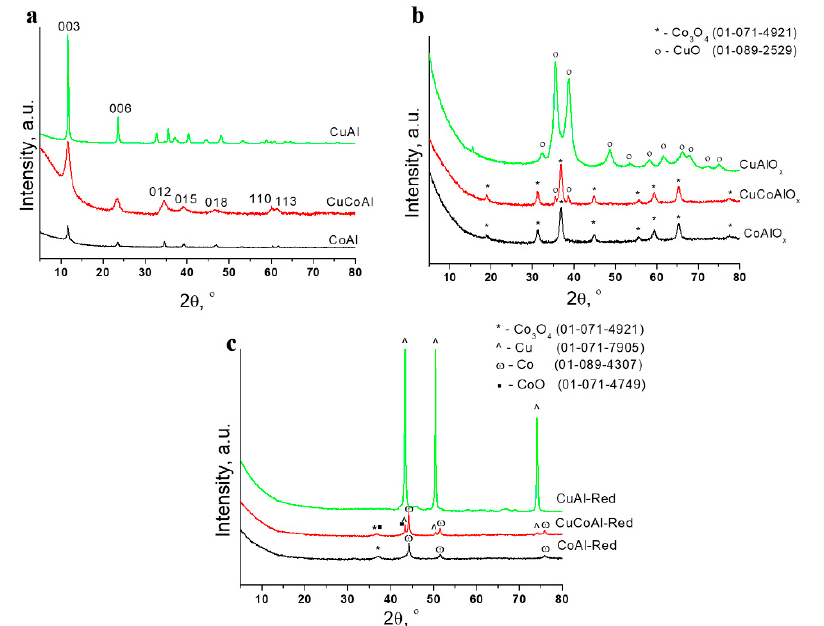
Figure 1. XDR patterns of the as-synthesized samples ( a ), samples, calcined at 550 ◦ C ( b ), samples, calcined at 550 ◦ C and then reduced at 800 ◦ C ( c ). The intensity of CuAl peaks (for as-synthesized sample) was reduced by 10 times.